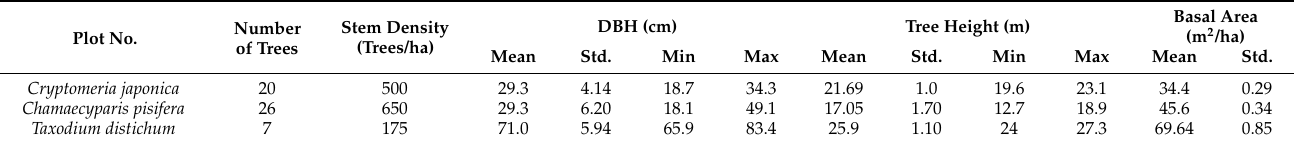
Table 3. Summary statistics for the sample trees in each sample